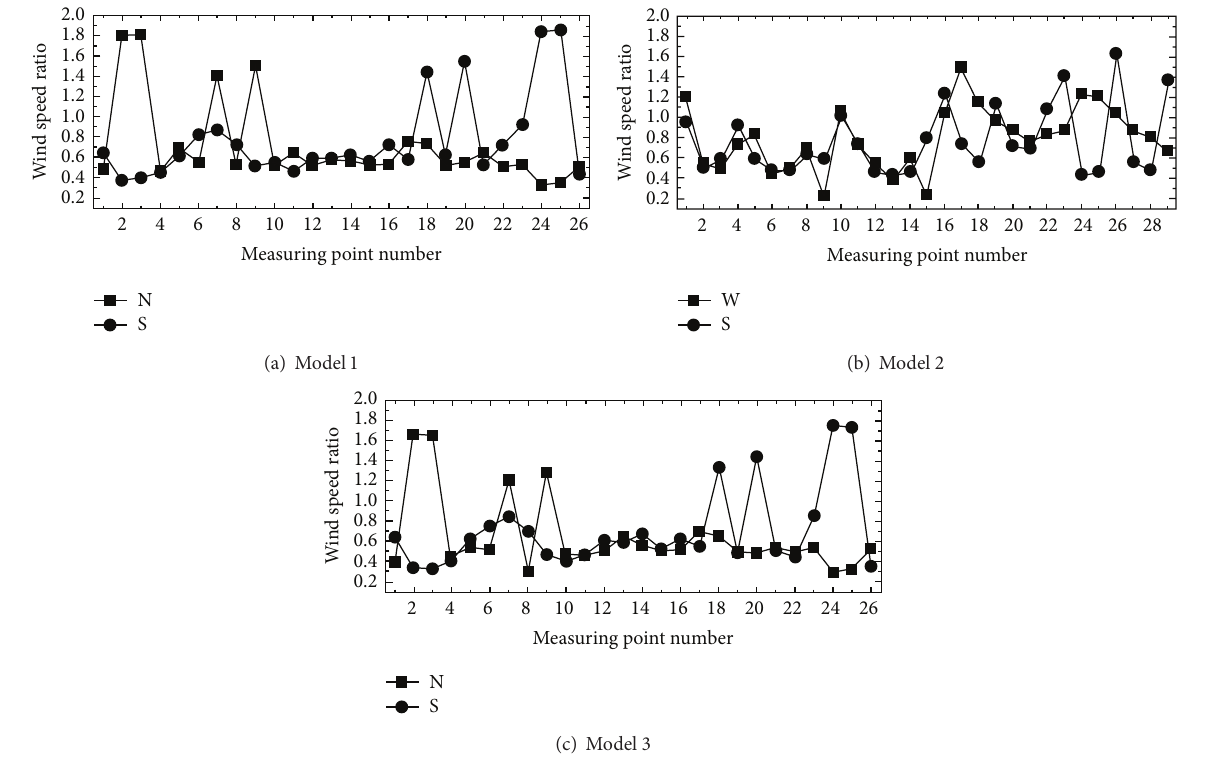
Figure 6: Wind speed ratio at each measurement point with respect to wind angle